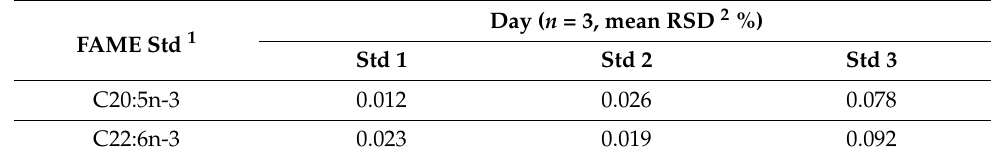
Table 3. The mean intermediate precision (RSD%) of the FA determined in fish samples. FAME Std